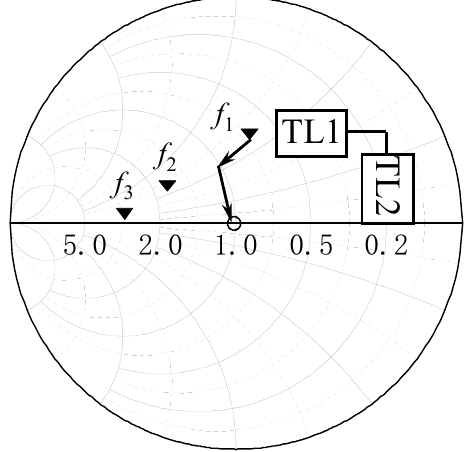
Figure 2. The matching circuit for the first frequency band.